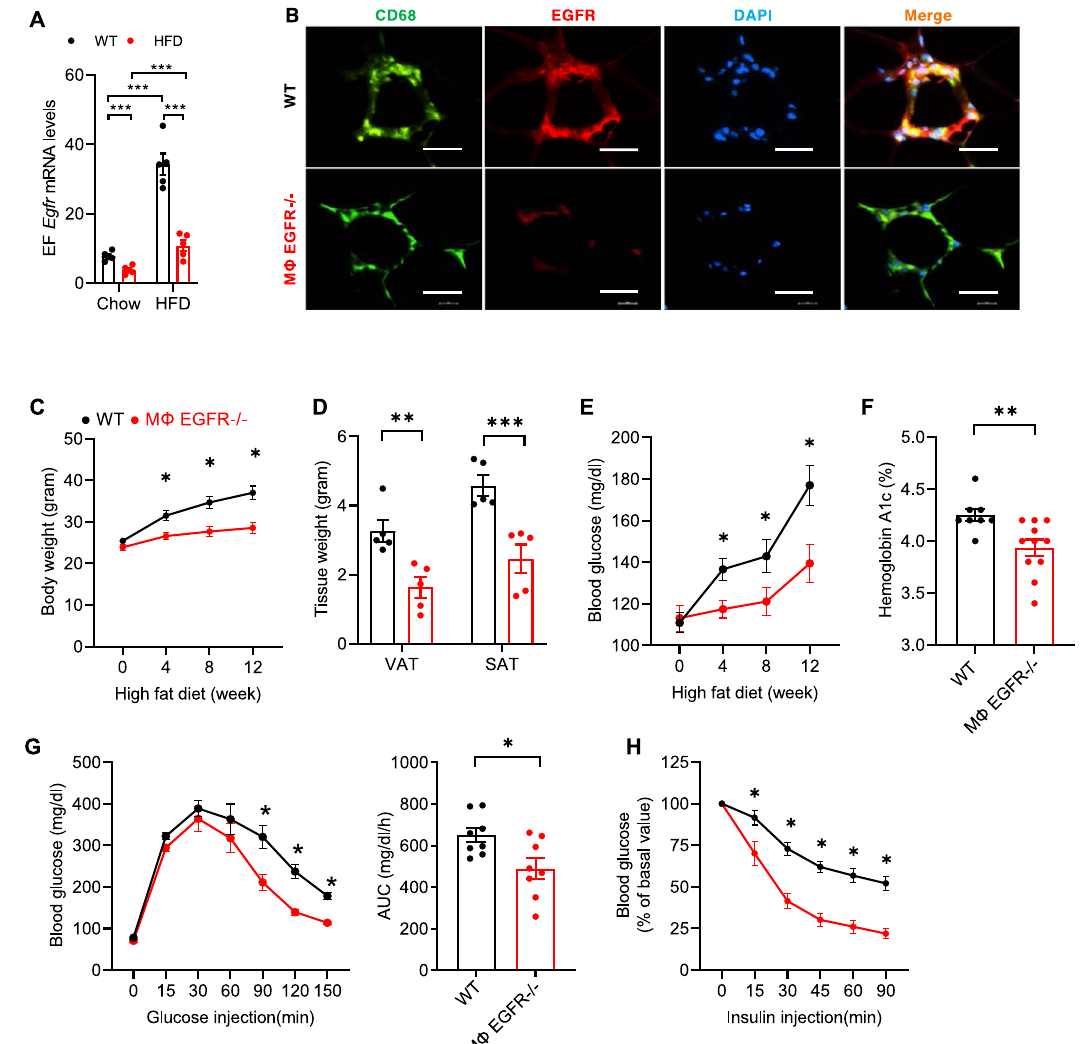
Fig. 3 | Myeloid EGFR de fi ciency attenuated insulin resistance in diet-induced obesity. WT (EGFR f/f ) mice and M Φ EGFR − / − (CD11b-Cre; EGFR f/f ) mice were fed the HFDfor12weeks. A Epididymalfat(EF) Egfr mRFNAlevelsweremarkedlyincreased in WT mice response to the HFD. M Φ EGFR − / − mice had markedly lower EF Egfr mRNA levels compared to WT mice with chow food or with the HFD. N =5. B Representative images showed that EGFR immuno fl uorescence was minimal in M Φ EGFR − / − mice but clearly evident in ATMs in WT mice. Scale bar=100 μ m. C – F M Φ EGFR − / − mice had reduced increases in body weight ( n =10 and